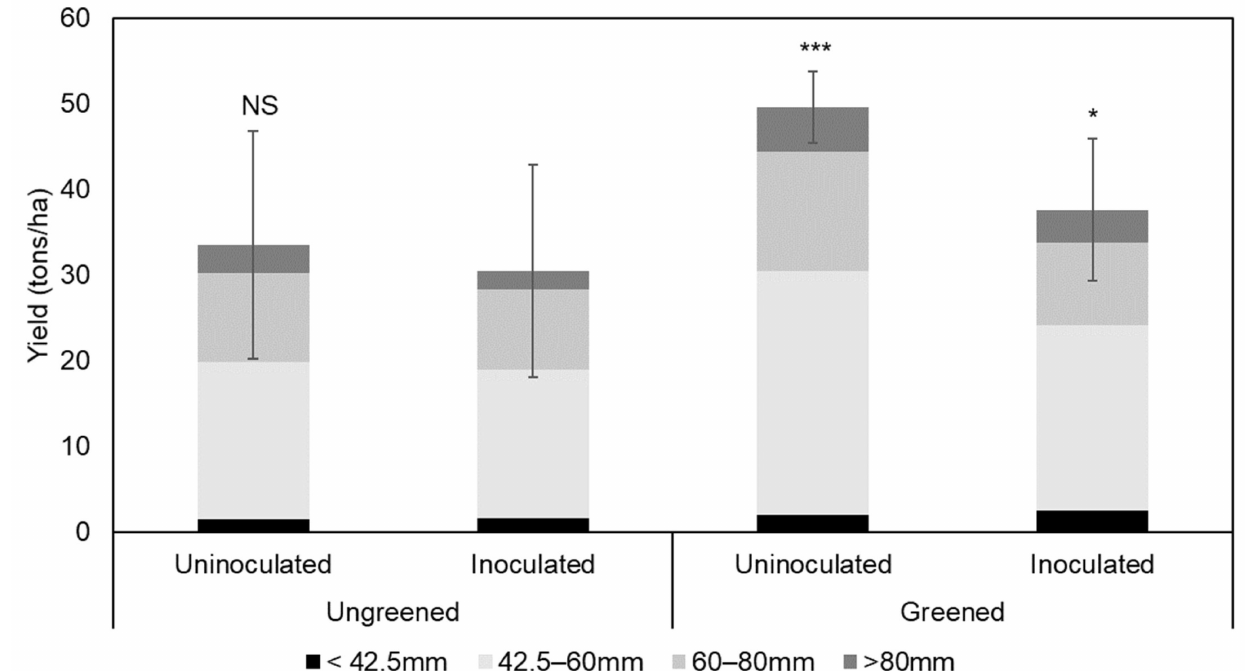
Figure 4. Average potato yield observed cumulatively for the years 2019 and 2020. The results of the mean comparison Dunnett test for the commercial yield (42.5 to 80 mm) are presented in brackets: (NS) for “non-significant”; (*) for p < 0.05; (***) p < 0.001. Each treatment is compared with the inoculated and ungreened treatments. The error bars represent the standard deviations of the commercial